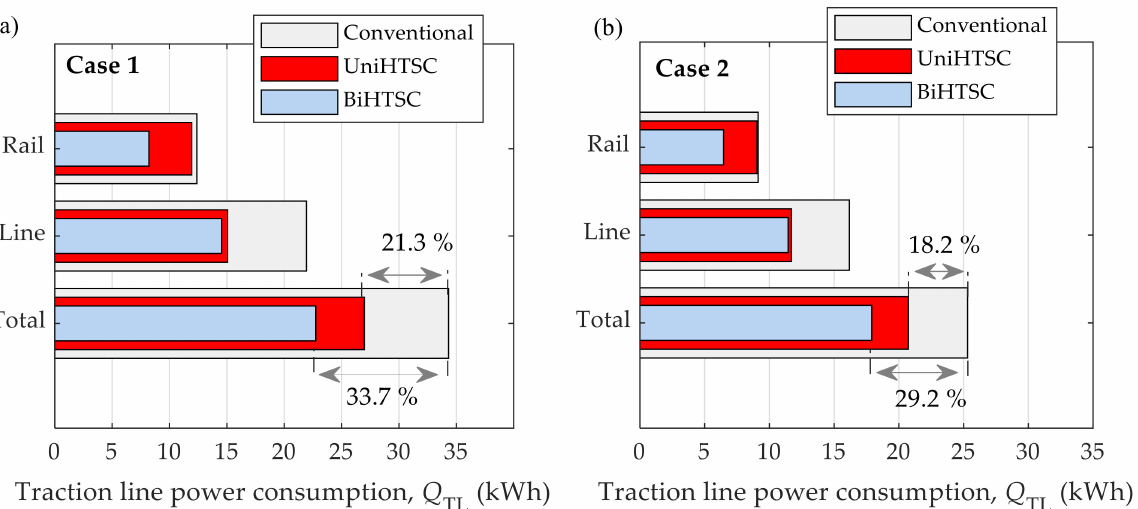
Figure 20. Consumption of the traction line for the 3 cable technologies. ( a ) Scenario 1, both trains have the same dynamic behavior; ( b ) scenario 2, the trains have different dynamic